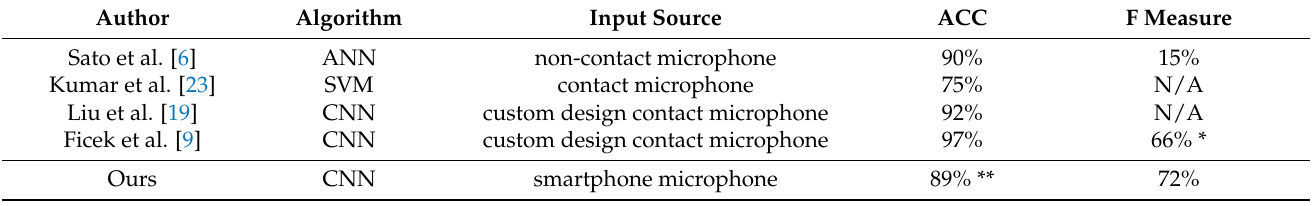
Table 5. Summary of recent bowel sound algorithms. This summary is based largely on the results in Table 10 of Ficek et al.